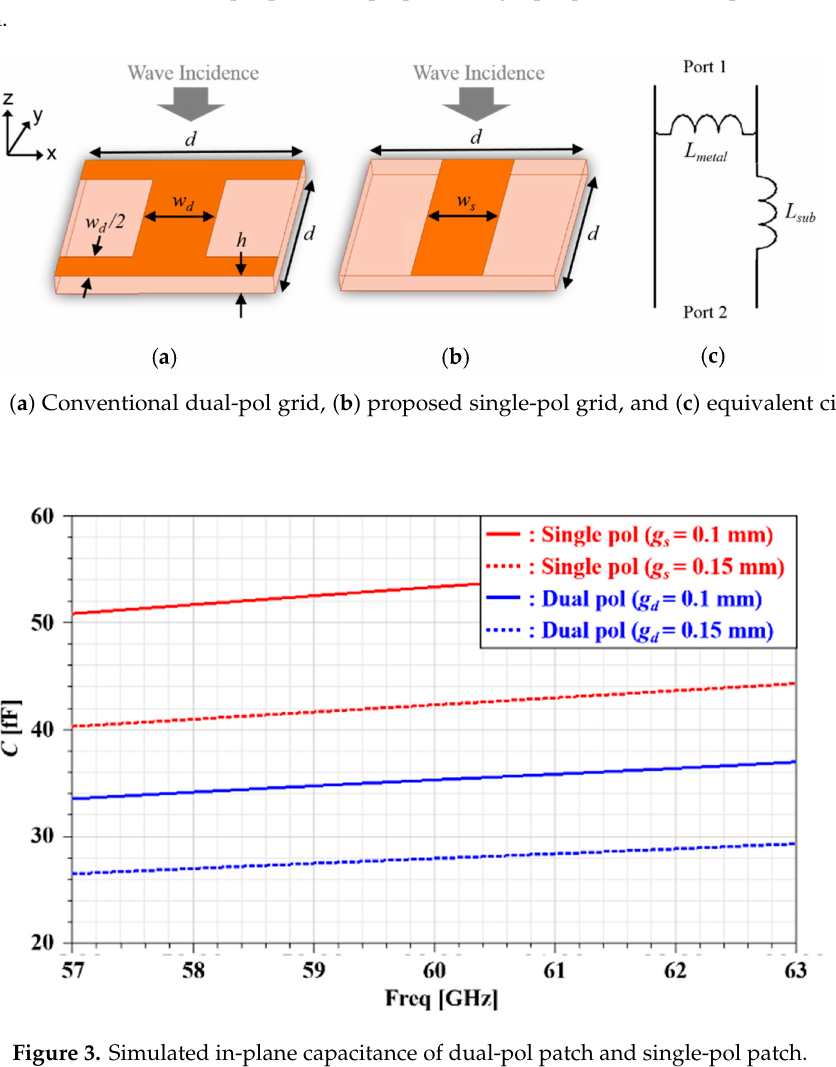
Figure 3. Simulated in-plane capacitance of dual-pol patch and single-pol patch.